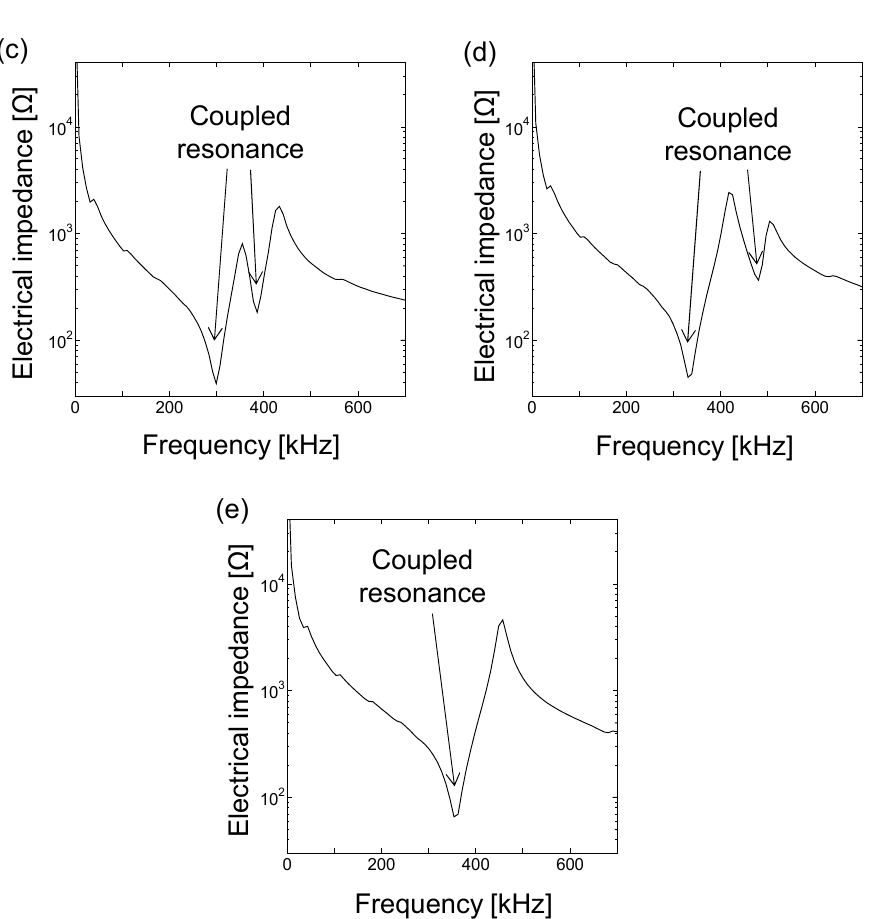
Figure 3. Electrical impedance calculated by 2D FE analysis with various element widths and a fixed thickness of 4 mm. Element width: ( a ) 8 mm, ( b ) 6 mm, ( c ) 4 mm, ( d ) 3 mm, and ( e ) 2 mm.